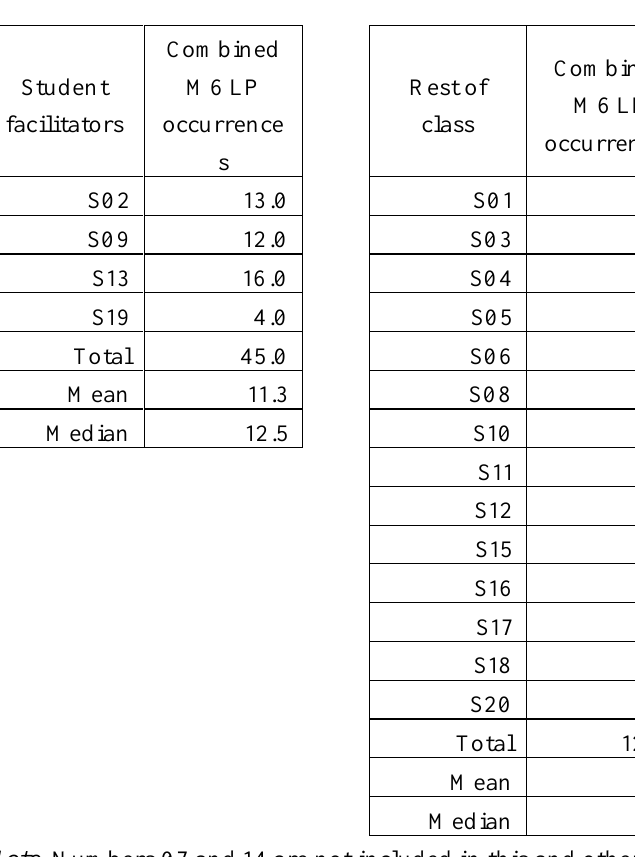
Table 1 Comparison of Average Combined Learning Presence (LP) of Student Facilitators and the Rest of the